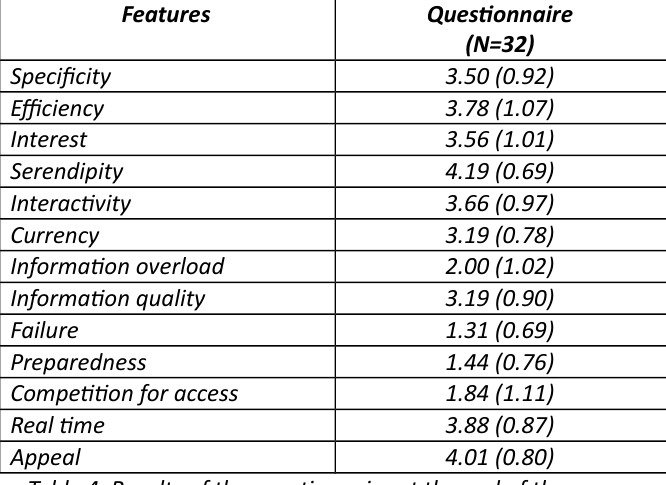
Table 4. Results of the questonnaire at the end of the